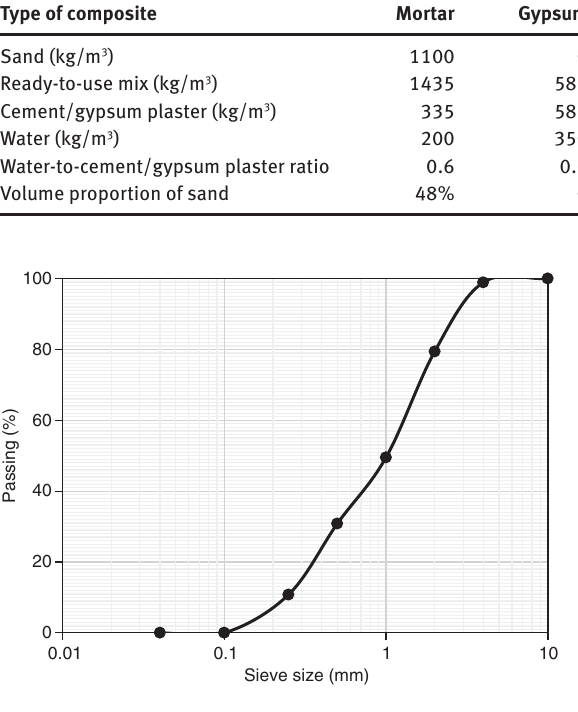
Figure 1: Results of sieve analysis of